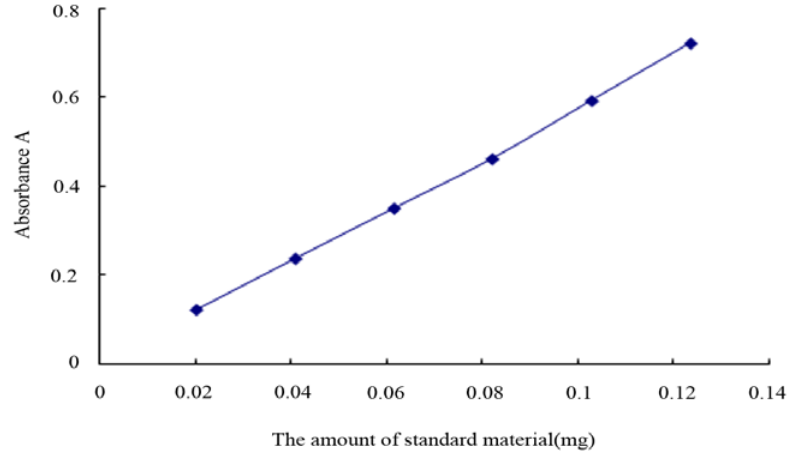
Figure 1. Ursolic acid standard curve.